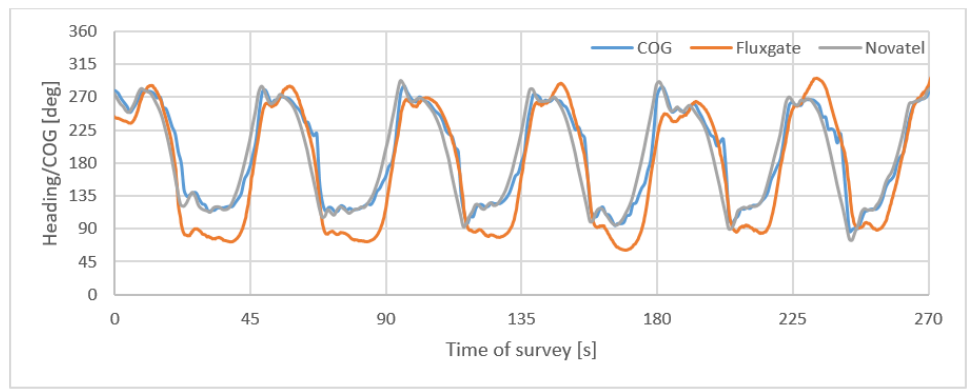
Figure 10. Satellite compass and fluxgate headings and COG during 270 s survey on short profiles with quick heading changes. with quick heading changes.